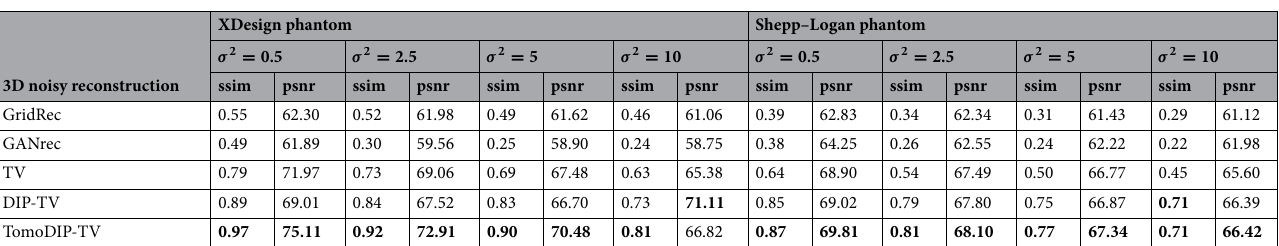
Table 2. Quantitative comparison of reconstruction qualities from noisy projections between 0 ◦ and 150 ◦ (Best SSIM and PSNR results per noise level are shown in